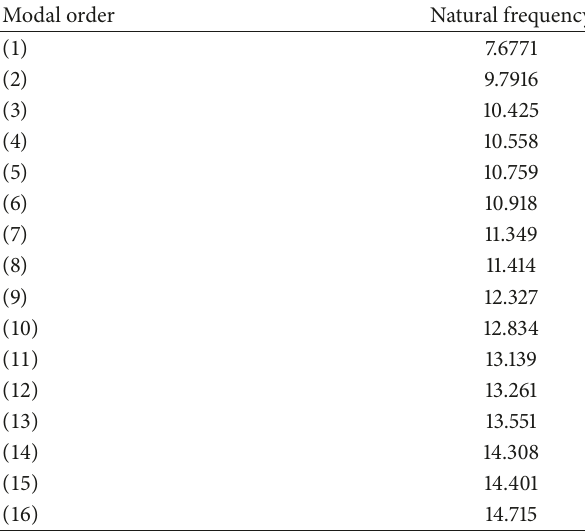
Table 4: Natural frequencies of the system (2nd approach).